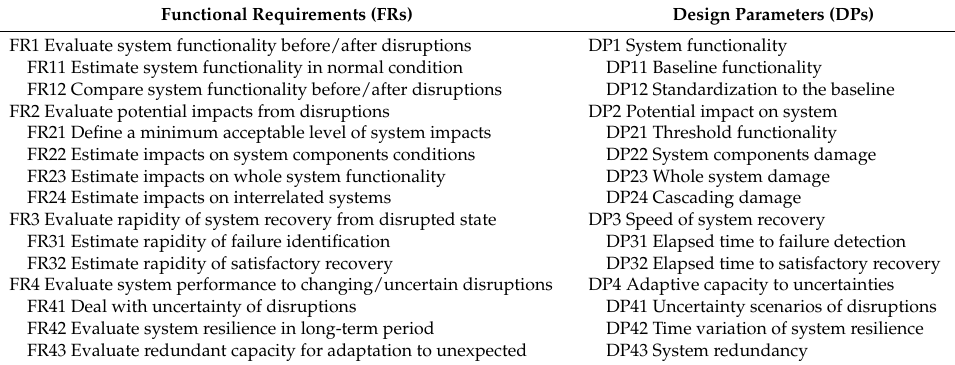
Table 2. FRs and DPs for resilience